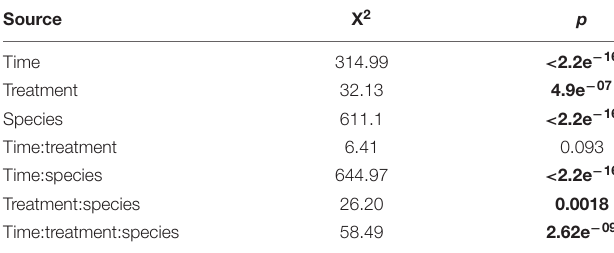
TABLE 1 | Results of the Wald statistic of the GEEGLM: Effect of treatment ( E. coli , low, medium, and high) and species (Pm I, Pm II, Pm III, and Pm IV) on the total number of adults over